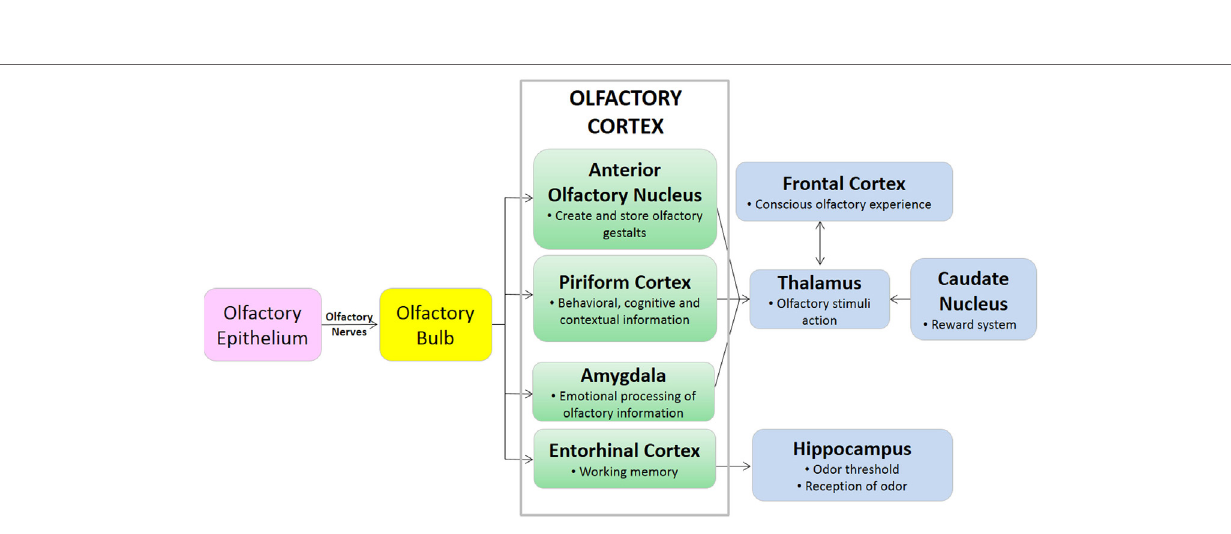
FigURe 2 | Diagram of pathway demonstrating olfactory signaling